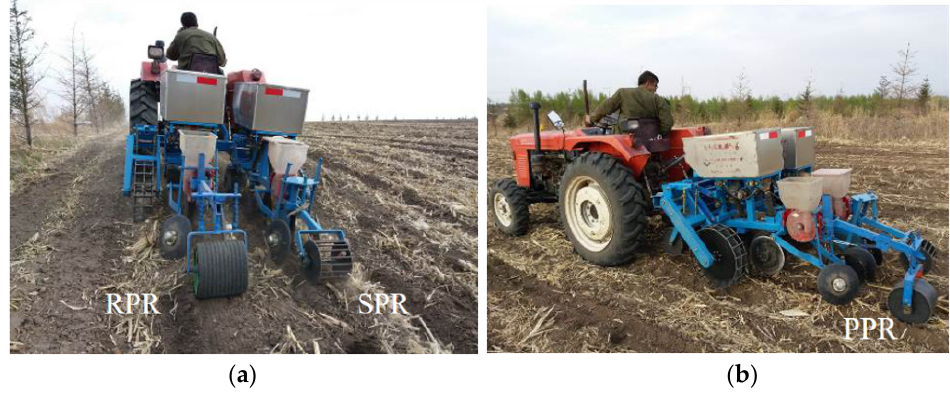
Figure 6. The types of press rollers: ( a ) the RPR and SPR ;( b ) the PPR and SPR.